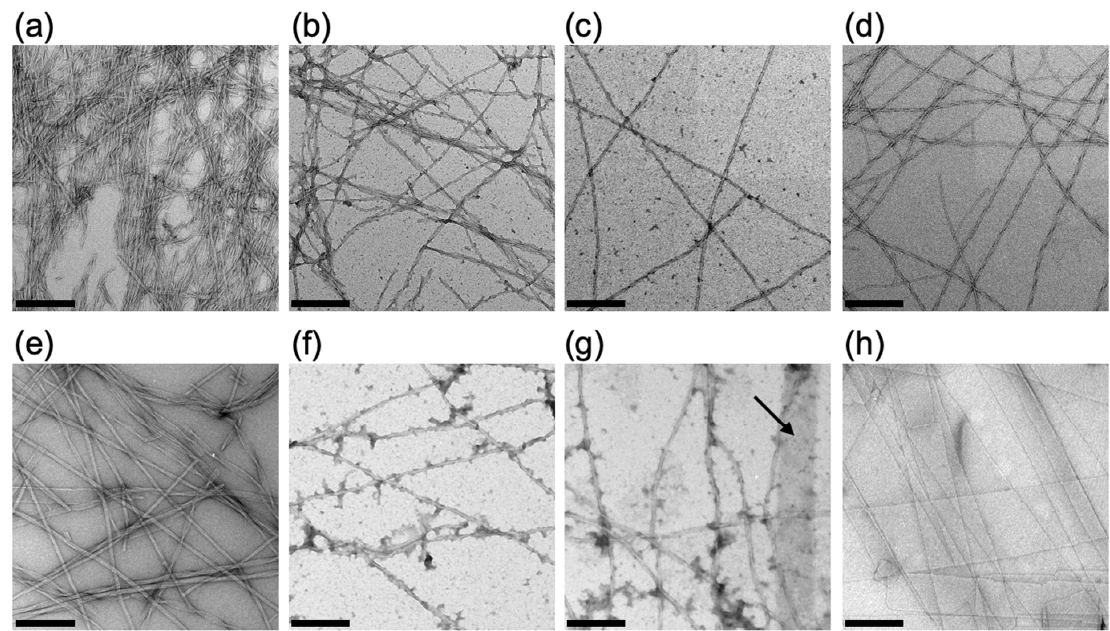
Figure 4. Transmission electron microscopy (TEM) images of Fmoc-L 2 QG ( a – d ) and Fmoc-L 3 QG ( e – h ) at pH 5 ( a , e ), 6 ( b , f ), 7 ( c , g ), and 8 ( d , h ). Fmoc-L 2 QG assemblies formed a narrow fibrous structure with twisting ( a – d ). Fmoc-L 3 QG assemblies formed a similar structure at pH 5–6 ( e , f ), while they transformed into a wide, flat tape-like structure as the pH increased ( g , h ). Arrow in ( g ) indicates the flat tape-like structure. Bars: 200 nm.